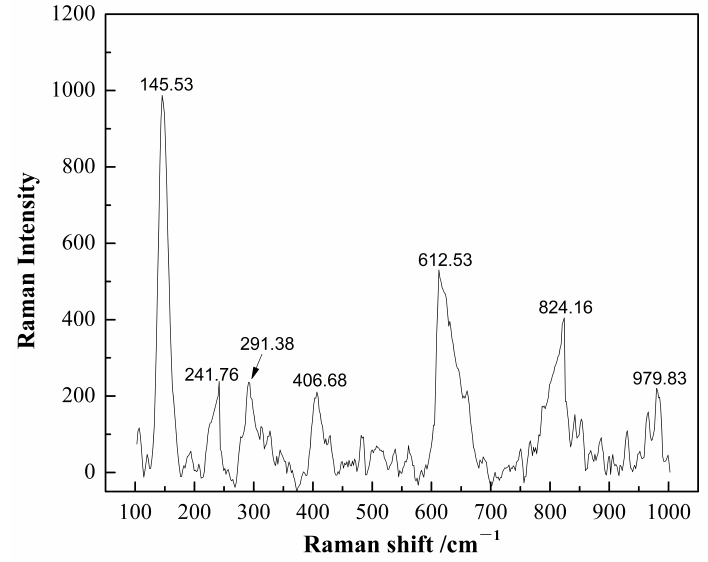
Figure 1. Raman spectra of TiO 2 passivation film on TC4 titanium alloy